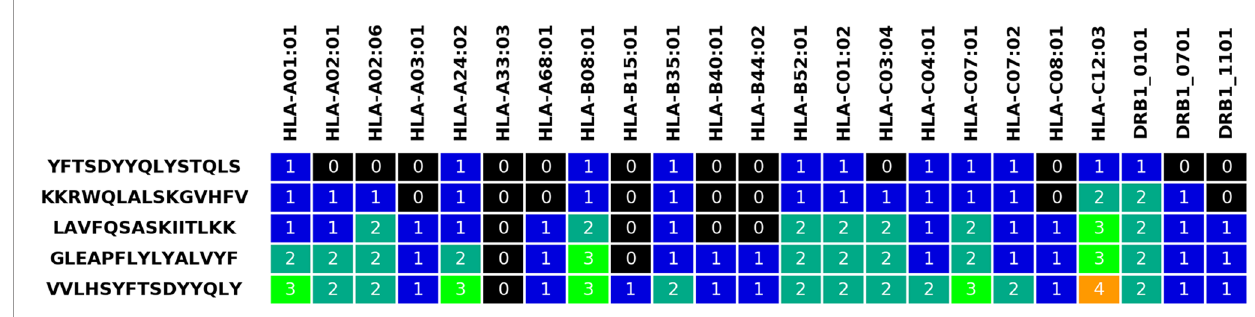
TABLE 1 | Coverage metrics of the peptides selected from the HIV dataset using PopCover-1.0 and PopCover-2.0.